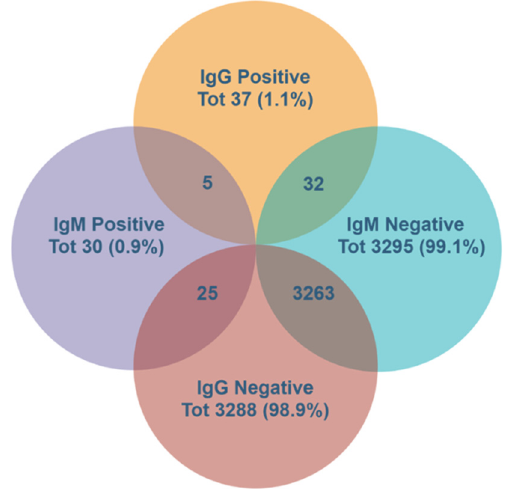
Figure 1. Serological diagnosis of severe acute respiratory syndrome coronavirus 2 (SARS-CoV-2). Summary of IgG and IgM results among the healthcare workers.